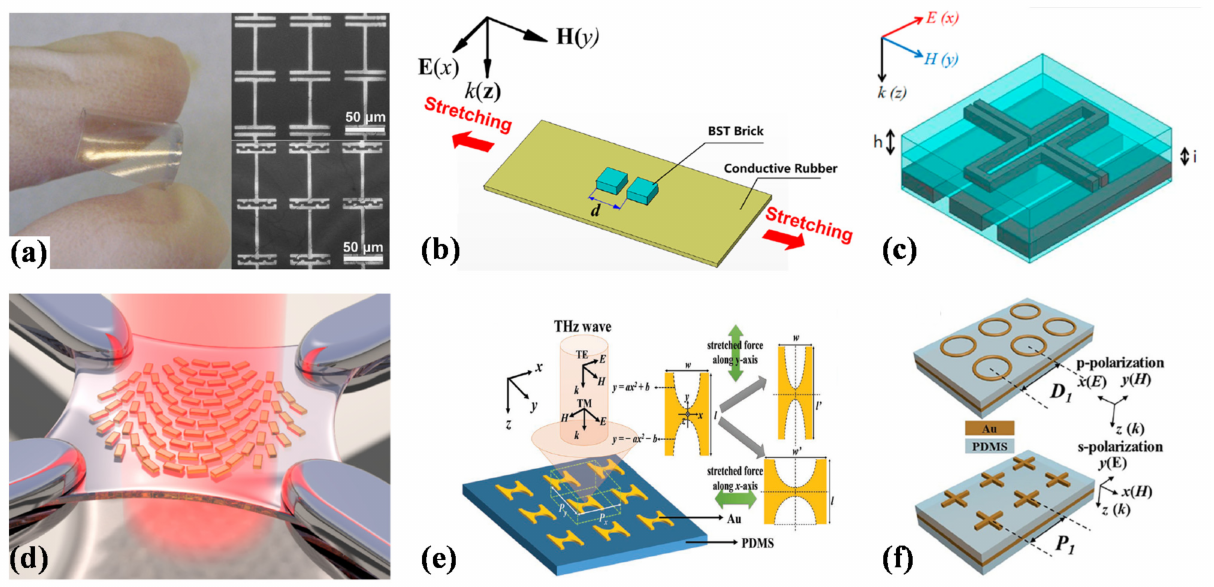
Figure 7. Flexible substrate-based metamaterial: ( a ) photograph and optical micrograph of I-shaped flexible metamaterial design [97]; ( b ) schematic of stretchable dielectric metamaterial absorber [98]; ( c ) schematics of stretchable metamaterial absorber by using liquid metal as the conductor and PDMS as the substrate [99]; ( d ) schematic of a gold nano-rod metasurface array on stretched PDMS [100]; ( e ) schematic of the PSM device operated by applying a stretching force along the x- and y -axis directions [49]; ( f ) schematics of stretchable perfect absorber with ring-shaped (PA-RS) and cross- shaped (PA-CS) structures